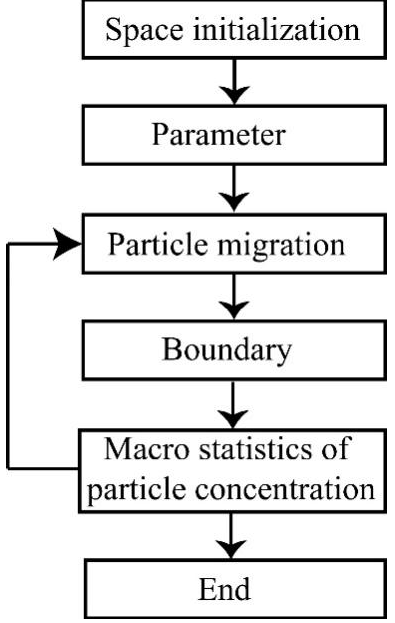
Figure 1. Simulation